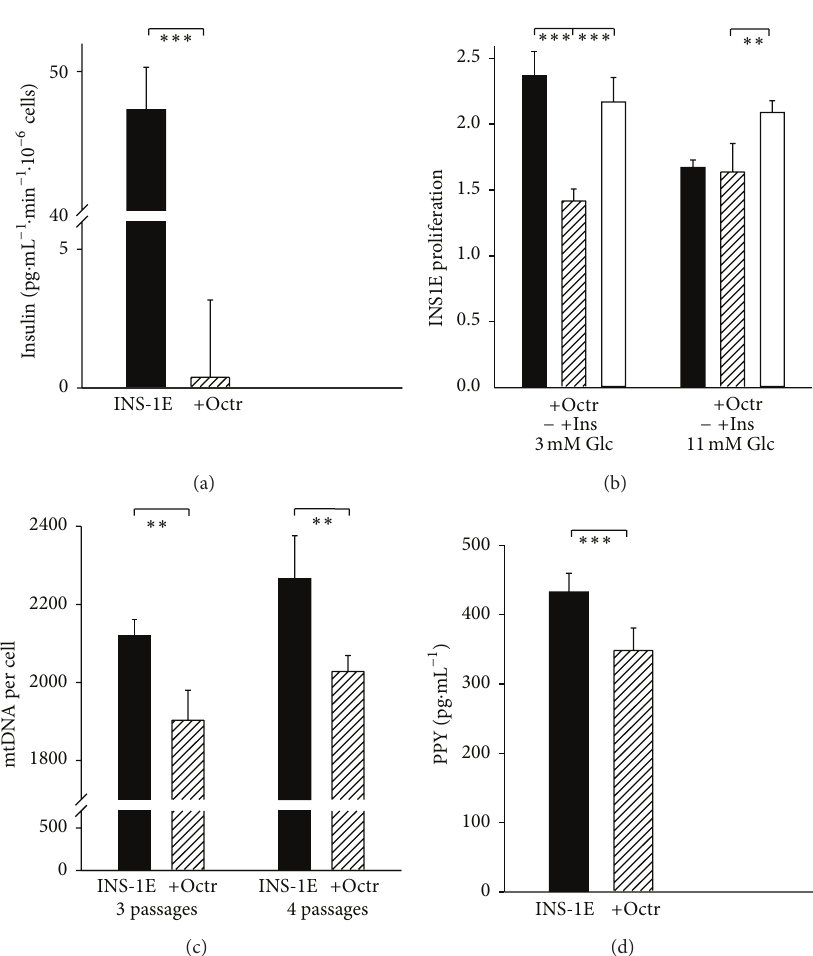
Figure 6: Octreotide effect on insulin release, proliferation, mtDNA, and PPY secretion of INS-1E cells. (a) Glucose-stimulated insulin release from INS-1E cells, evaluated as the difference between time courses assayed with 25 mM glucose and without glucose up to 30 min, in the absence (black bar) and after a 60 min pretreatment with 50 nM octreotide (dashed bar); ∗∗∗ 𝑝 < 0.001 ( 𝑛 = 3 ). (b) Proliferation (relative number of cells related to zero time) of INS-1E cells for 3 various cultivations at 3 mM glucose “3mM Glc”, that is, at suppressed autocrine insulin, or at standard 11mM glucose, in the presence of 10nM octreotide (dashed bars) or octreotide plus supplemented 0.2 𝜇 M human insulin “+Ins” (white bars, ∗∗ 𝑝 < 0.01 ; ∗∗∗ 𝑝 < 0.001 ); (c) mitochondrial DNA copy number in INS-1E cells, after 3 or 4 passages “pass.” of cultivation in the absence (black bars) or presence of 1 𝜇 M octreotide (dashed bars, ∗∗ 𝑝 < 0.05 ; 𝑛 = 6 ). (d) PPY in medium of control (black bar) and octreotide-treated (1 𝜇 M, +Octr, dashed bar) INS-1E cells, after 3 passages of cultivation ( ∗∗ 𝑝 < 0.05 ; 𝑛 = 6 ).